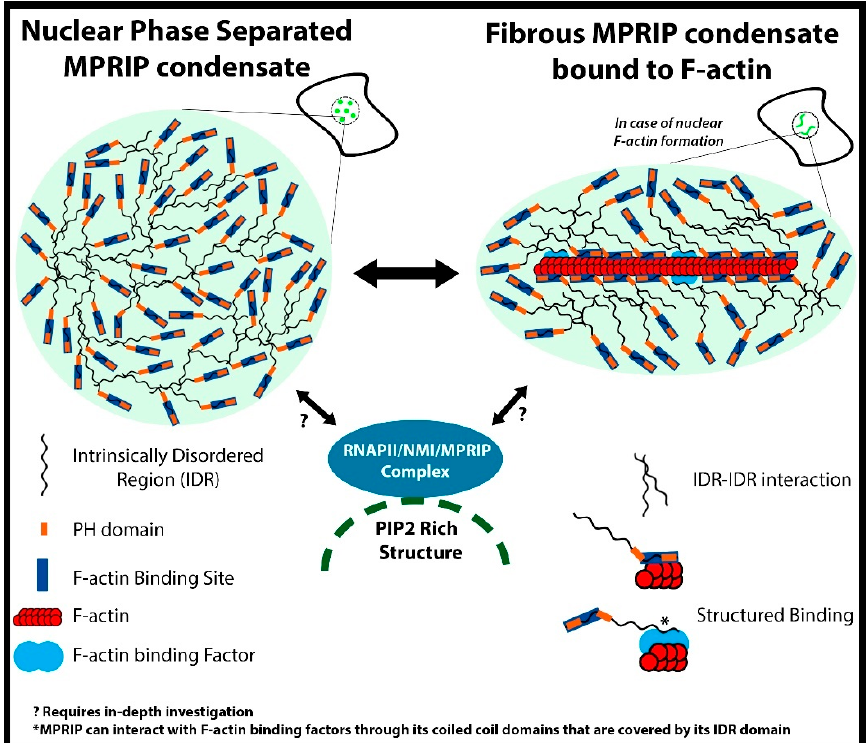
Figure 11. Illustration of the hypothetical model of interplay between MPRIP phase separation and its interactors. RNAPII/NMI/MPRIP complex localizes in the proximity of nuclear PIP2-rich structures. The MPRIP protein contains two PH domains, an F-actin binding site and C-terminal IDR. MPRIP is able to form phase-separated condensates through IDR interactions. These conden- sates can form fibers when associated with nuclear F-actin. (*) This association is mediated either by intrinsic MPRIP F-actin-binding site or by other F-actin binding factors. (?) It remains unclear how MPRIP/RNAPII/NM1/PIP2 complex formation depends on the phase separation, actin polymerization or association with PIP2-rich nuclear structures. It also needs further clarification consequent transcriptional output of the